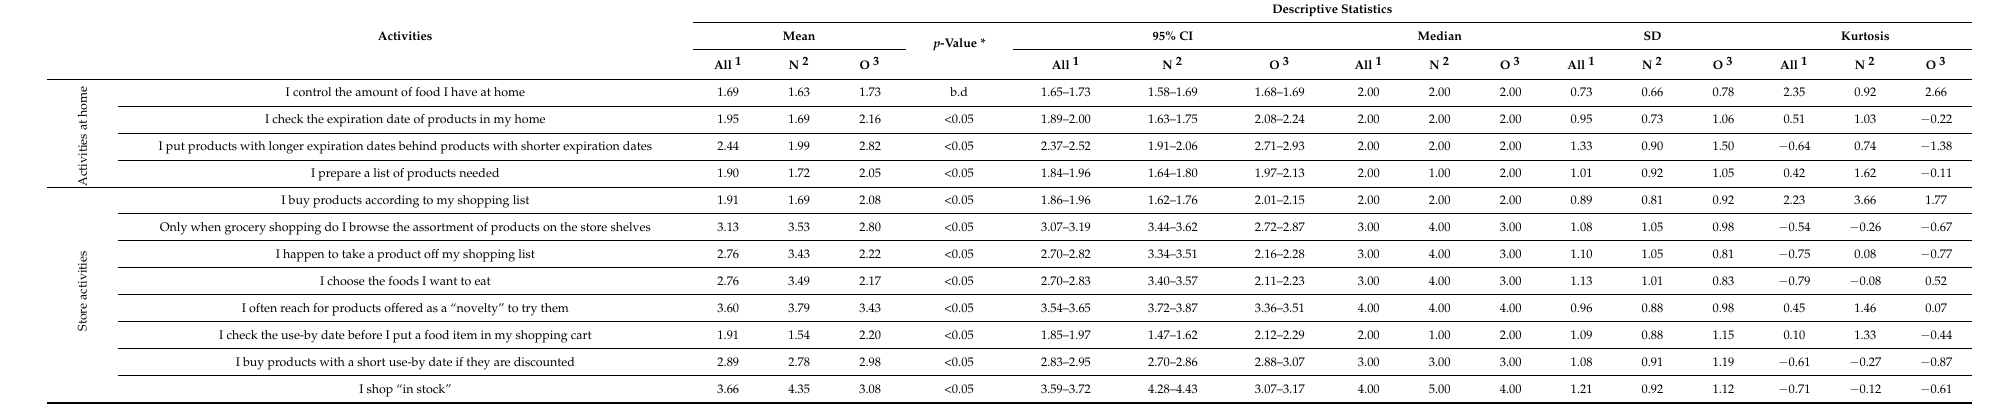
Table 2. Mean, confidence interval (CI), median, standard deviation (SD), and kurtosis for shopping behavior and home and store